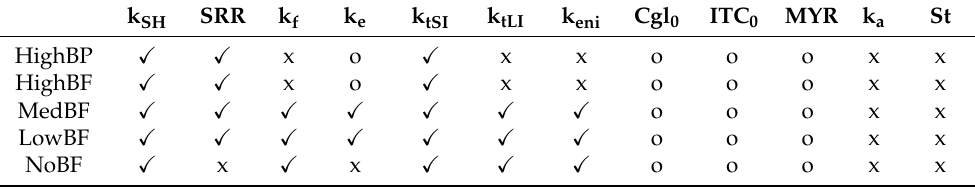
Table 2. Summary of parameters that influenced the simulation outputs for each broccoli product during the sensitivity analysis. Parameters with a check mark ( (cid:88) ) were used for model fittings; parameters with an O, influenced simulation output but were not used in model fittings; parameters with an x did not affect output during the sensitivity analysis and were excluded from fitting. Three parameters were used to fit HighBP and HighBF, seven for MedBF and LowBF, and five for